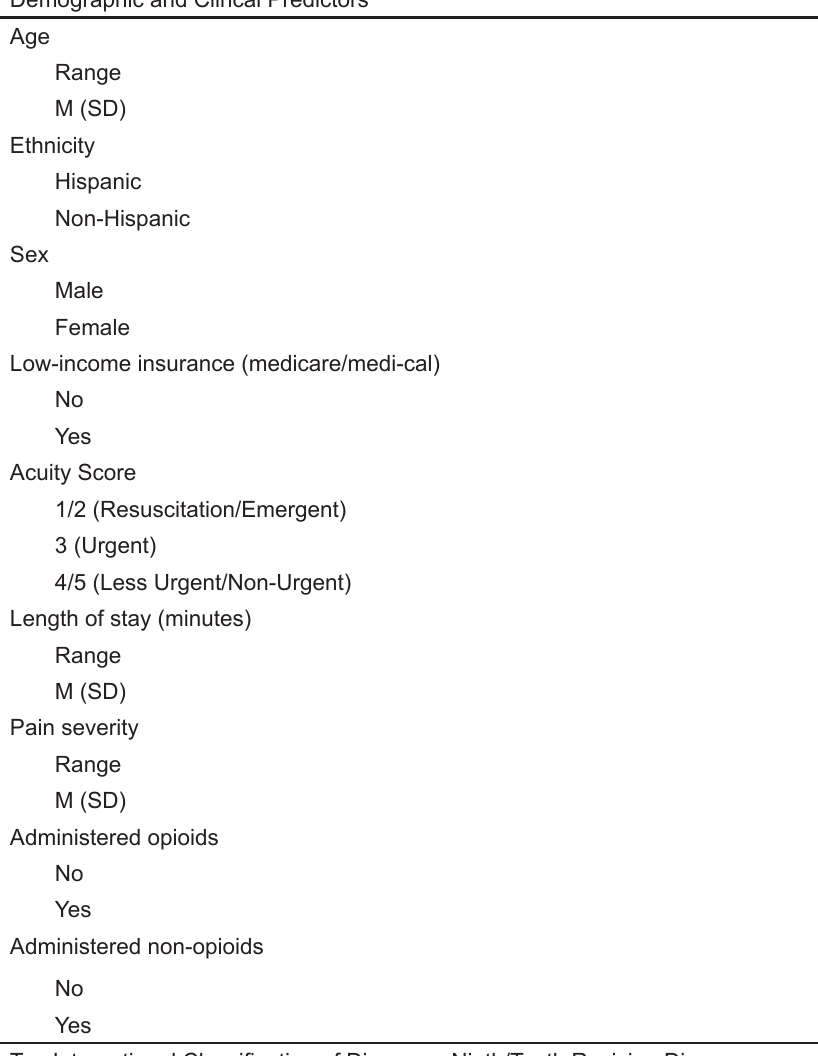
Table 1. Pediatric patient sample characteristics (N =